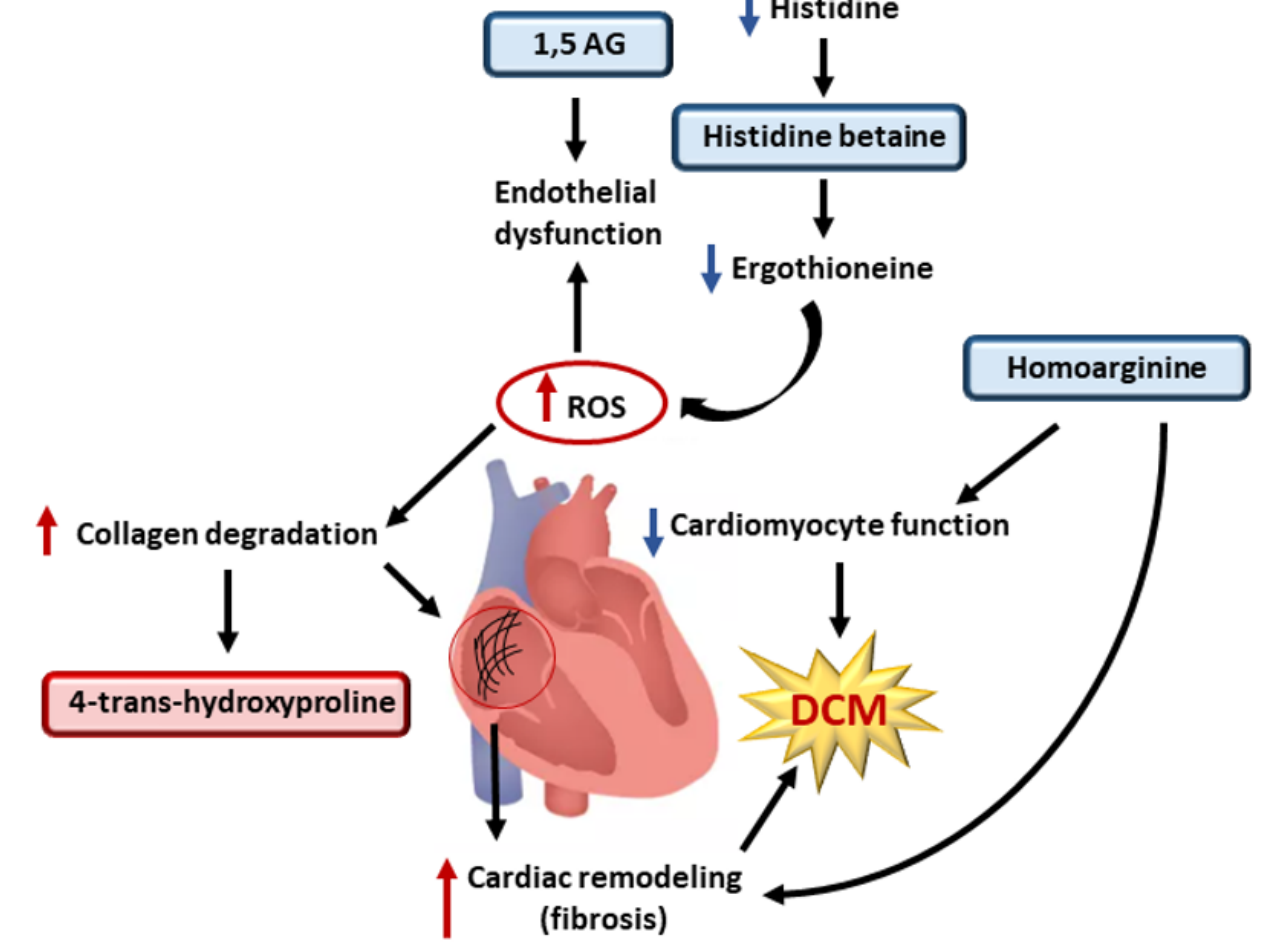
Figure 2. Metabolites involved in the generation of reactive oxygen species, collagen degradation, and cardiac remodeling in the carriers of pathogenic DCM variants. Red boxes indicate increased concentrations and blue boxes decreased concentrations of the metabolites in the carriers of the pathogenic genetic variants compared to the controls. Collagen degradation increases 4-trans-hydroxyproline concentrations and increases the rate of cardiac remodeling, leading to DCM. Decreased levels of histidine betaine lead to low concentrations of antioxidant ergothioneine, which increases the generation of ROS. ROS, in turn, increases collagen degradation and plays a role in endothelial dysfunction, which is also aggravated by decreased concentrations of 1,5 AG. Low concentrations of homoargi- nine decreases cardiomyocytes function and increases the rate of cardiac remodeling, triggering the development of DCM. Abbreviations: 1,5 AG, 1,5-anhydroglucitol; DCM, dilated cardiomyopathy; ROS, reactive oxygen